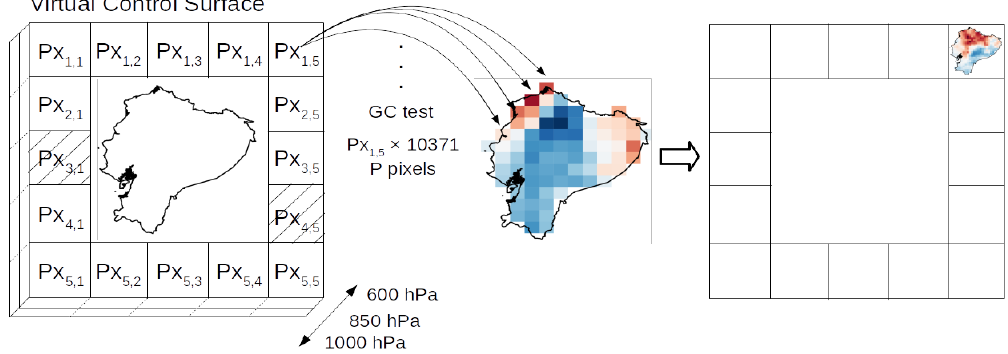
Figure 4. Experimental setup scheme. q and U at three pressure levels (1000, 850, and 600 hPa) from the control surface is Granger tested with CHIRPS rainfall anomalies (P) in the study zone. Corresponding to each pixel in the control surface at each pressure level (Px 1,1 , Px 1,2 , etc.), there is a map with Granger causality (GC) test results. Dashed pixels Px 3,1 and Px 4,5 were taken as representatives to compare eastern and western connections to rainfall in the